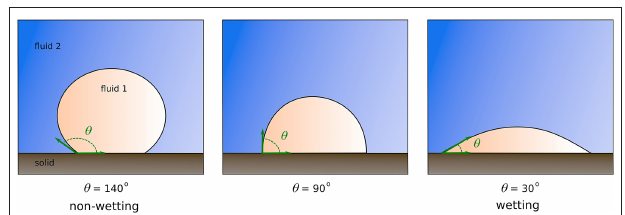
FIGURE 5 | The contact angle, θ , is the angle formed by the tangent to the solid surface and the tangent to the fluid-fluid interface. For values smaller than 90 ◦ , a droplet lying on a solid substrate tends to spread over the surface. The fluid within the droplet is the wetting fluid with respect to the other fluid and the solid surface. For values larger than 90 ◦ , the droplet is the non-wetting phase and tends to minimize its surface area in contact with the solid